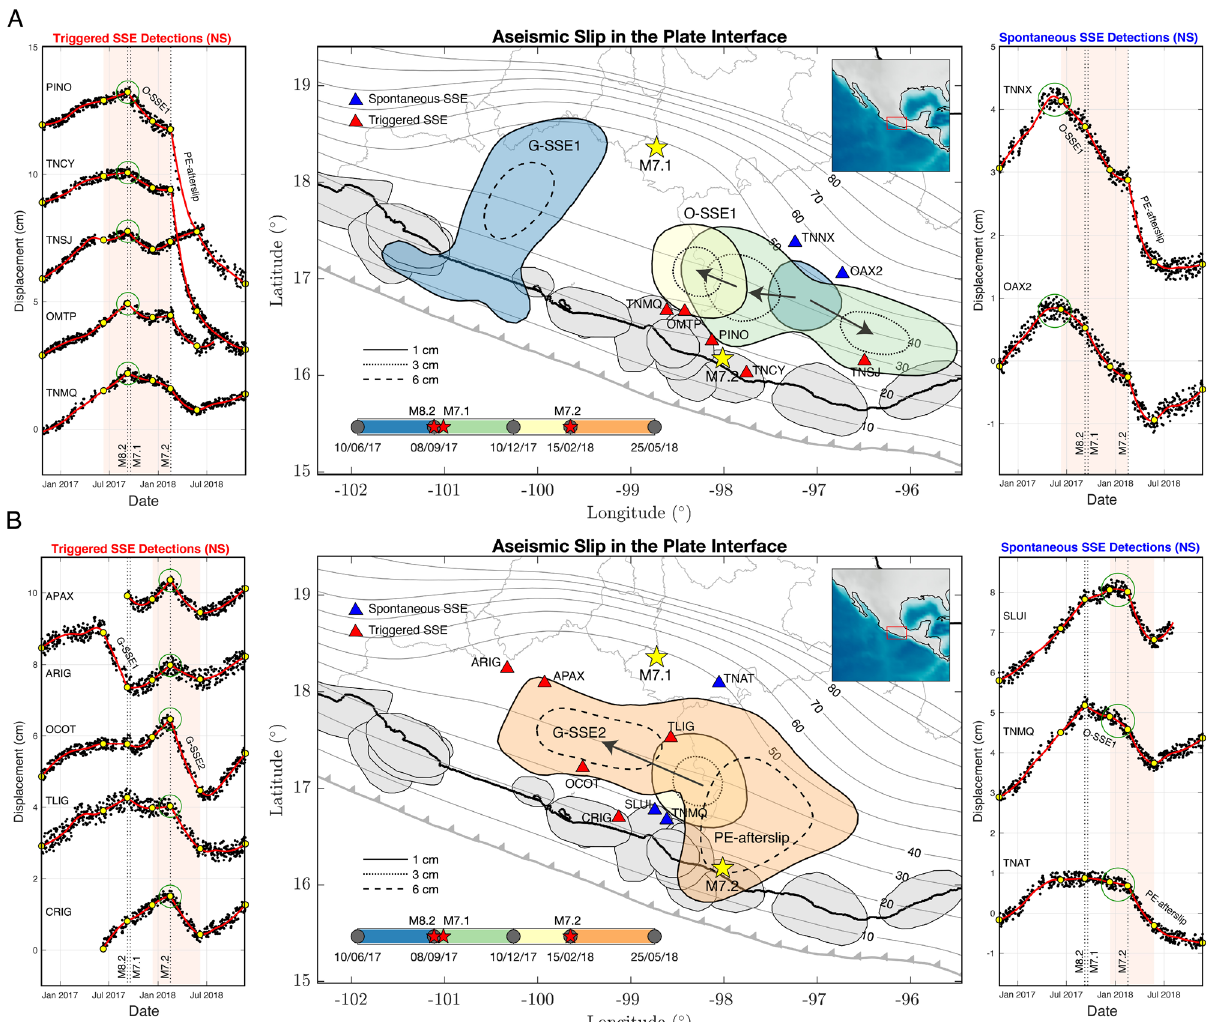
Fig. 4 Evolution of the plate interfaces aseismic slip (SSEs and afterslip) during the earthquake sequence (separated in two parts) and representative GPS time series (north-south components). The fi rst part (panel A ) before the M7.2 Pinotepa earthquake and the second part (panel B ) after the earthquake. Pink shaded rectangles encompass the GPS windows (yellow dots) that were slip-inverted in the central maps (color areas) for each panel. Blue triangles show GPS stations where we observe spontaneously initiated or preexistent SSEs at the time of earthquakes (right panels, green circles), while red triangles show the stations where we observe triggered SSEs also at those times (left panels, green circles). Notice the abrupt reversal of the deformation pattern in the left panels (from north to south, green circles) right at the moment of the Mw8.2 Tehuantepec and Mw7.2 Pinotepa earthquakes. Gray contours show iso-depths (in kilometers) of the 3D plate interface and gray shaded regions the rupture areas of historical